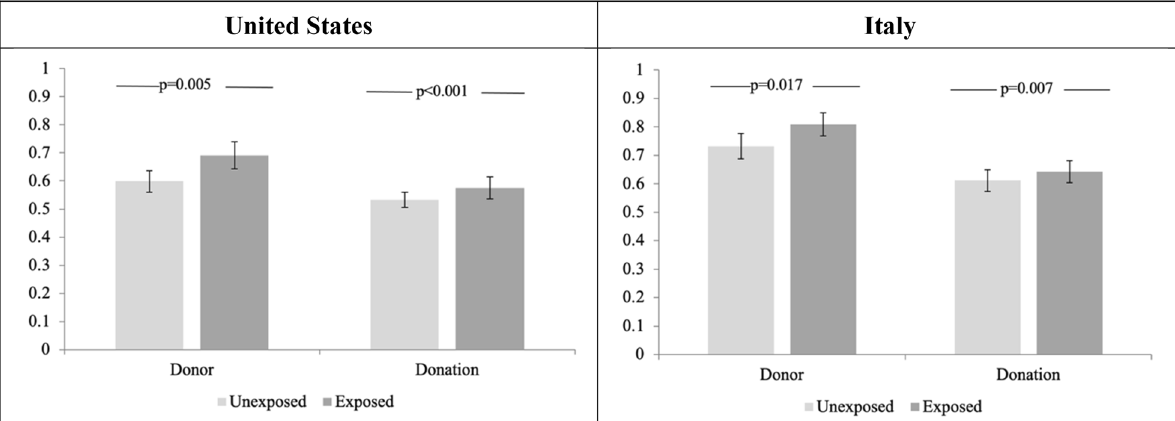
Figure 1. Impact of personal exposure to COVID-19 on frequency of donations and amount donated. ‘ Donor’ is a dichotomous variable taking value of 1 if a participant donated a positive sum to a charity, and 0 otherwise. ‘Donation’ is the amount donated, as a share of the bonus available for donation. The two panels report the means of the two variables, broken down by participants personally unexposed and exposed to COVID-19 in U.S. and Italy. Participants were identified as “Exposed” if they, their family members, or their acquaintances, had been diagnosed with or had died from COVID-19. Unexposed participants were all others. The whiskers denote 95% confidence intervals obtained from bootstrapped errors with 10,000 repetitions. The p -values report significance levels of a Fisher exact test (for ‘Donor’) and of a Mann–Whitney Wilcoxon test (for ‘Donation’) that the observations for Exposed and Unexposed individuals come from the same